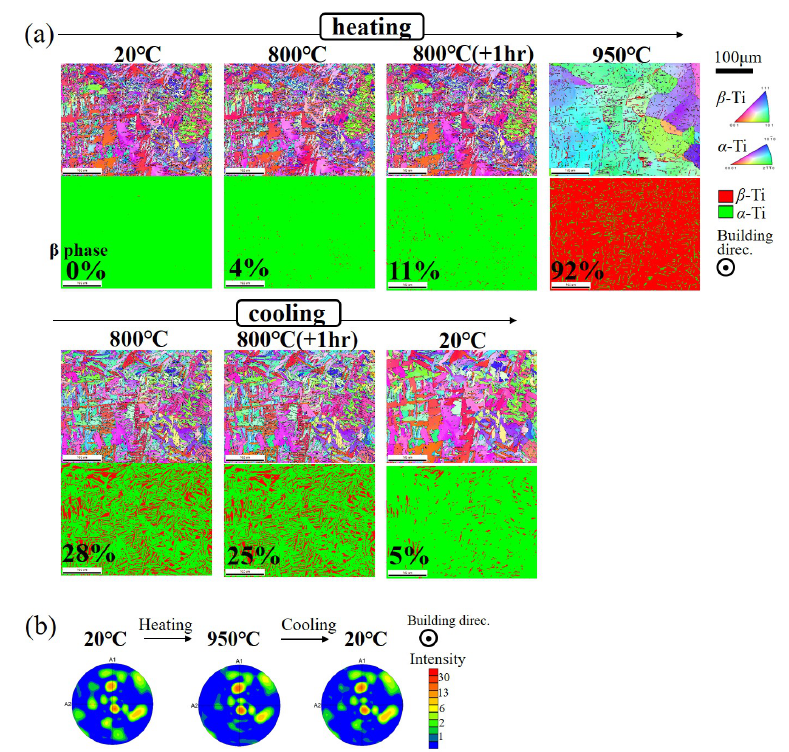
Figure 9. ( a ) Changes in inverse pole figure maps ( upper ) and phase maps ( lower ). The black lines in the inverse pole figure indicate the grain boundaries with the misorientation angle of 15 ◦ or more. ( b ) Changes in { 10¯10 } pole figure of α phase measured using EBSD.